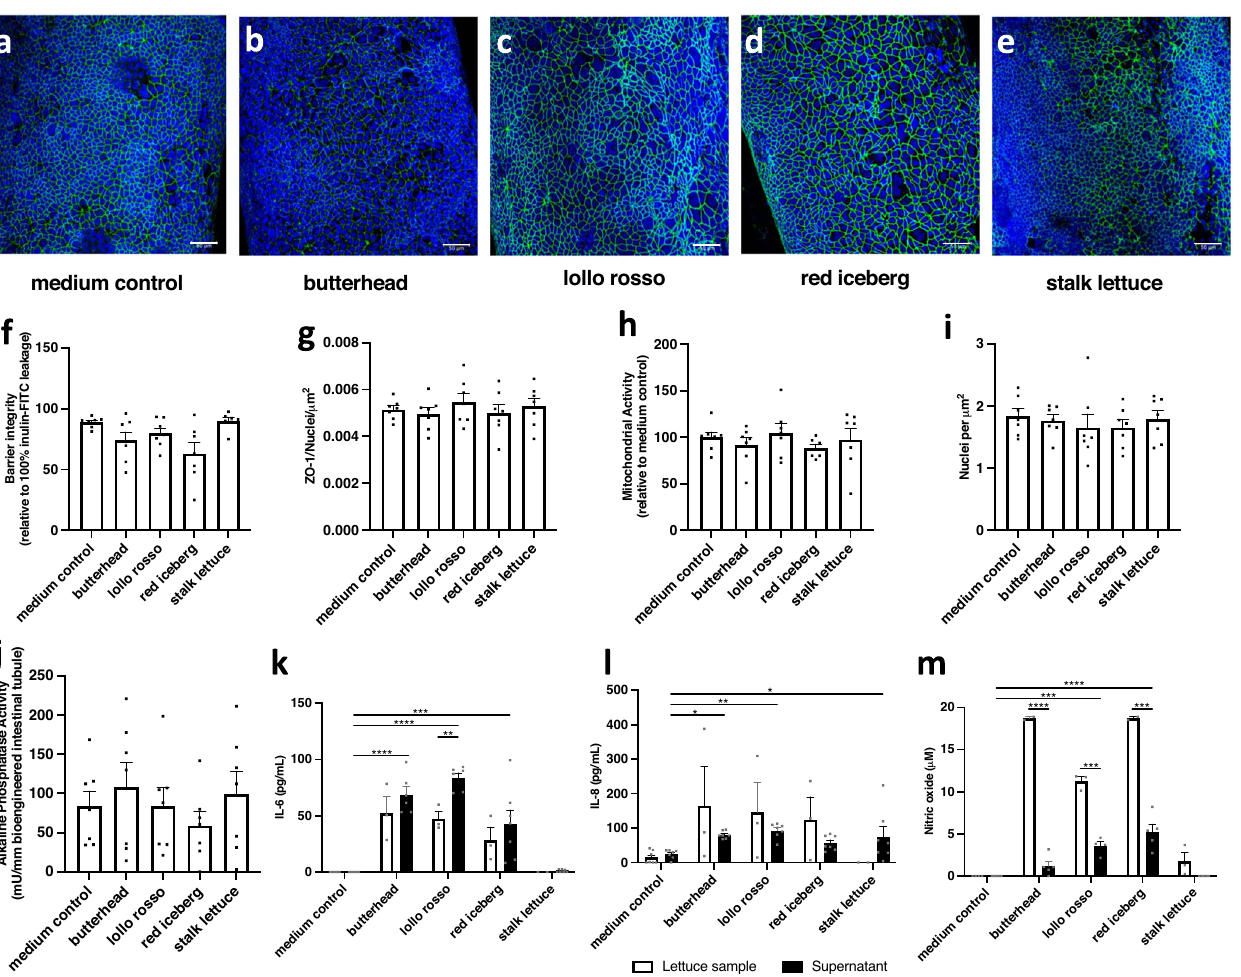
Fig. 2 Extracts from commercially available lettuce material do not disrupt the epithelial barrier or reduce cell viability in bioengineered intestinal tubules after 24 h exposure. a – e Representative immuno fl uorescent images of nuclei (blue) and zonula occludens-1 (ZO-1, green) for medium control, butterhead, lollo rosso, red iceberg, and stalk lettuce exposed bioengineered intestinal tubules, respectively. f , g Assessment of the intestinal epithelial barrier via inulin-FITC permeability f and ZO-1 quanti fi cation g . Inulin-FITC permeability data are expressed as a percentage (%) of the negative control, and ZO-1 quanti fi cation data were corrected for surface area and the number of nuclei. h The mitochondrial activity is a measure of cell viability. Data are relative to the cell cultivation medium without plant extracts. i The number of nuclei corrected for the surface area as a measure of cell attachment. j Brush border enzyme activity of alkaline phosphatase, a common Caco-2 enterocyte differentiation marker. k – m The secretion of interleukin (IL)-6, IL-8 and nitric oxide (NO), respectively. White bars ( n = 3) represent the concentration in lettuce extracts without exposure to tubules, whereas black bars visualize the concentration after 24 h exposure. Data are shown as mean ± SEM of n = 7 independent experiments. Data were corrected for outliers (6 outliers in 354 data points) and tested for signi fi cance using a t-test and one-way ANOVA. * p < 0.05, ** p < 0.005, *** p < 0.001 and **** p < 0.0001. Scale bar is 50